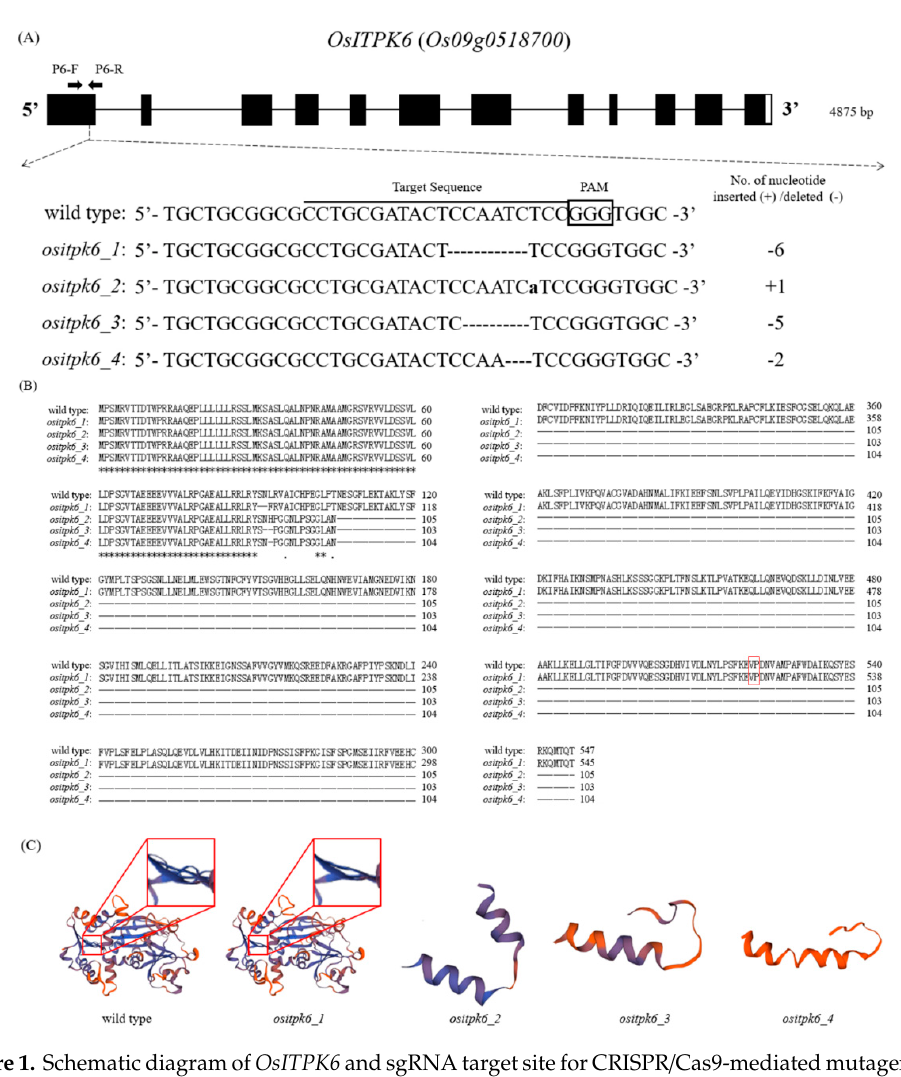
Figure 1. Schematic diagram of OsITPK6 and sgRNA target site for CRISPR / Cas9-mediated mutagenesis of OsITPK6 , and prediction of the related wild-type and mutant proteins. ( A ) Exons, introns, and UTRs are indicated by solid boxes, lines, and blank boxes, respectively. P6-F and P6-R are primers for mutation genotyping, and their positions are indicated by arrowheads. Mutation identified within the target site of OsITPK6 generated through CRISPR / Cas9-mediated genome editing in rice. The PAM sequences (NGG) are boxed, and the 20-nt target sequences are underlined. Mutations are shown in lowercase letters (for insertions) or ‘–’ (for deletions). ( B ) The amino acid sequences of mutant proteins were aligned to that of the wild-type protein using the Clustal Omega Multiple Sequence Alignment (https: // www.ebi.ac.uk / Tools / msa / clustalo / ). The numbers represent the total number of amino acids, and the amino acid V521 and P522 are highlighted in red box. ( C ) The three-dimensional structures of OsITPK6 and its mutants were analyzed on SWISS-MODEL (https: // www.swissmodel.expasy.org / ).